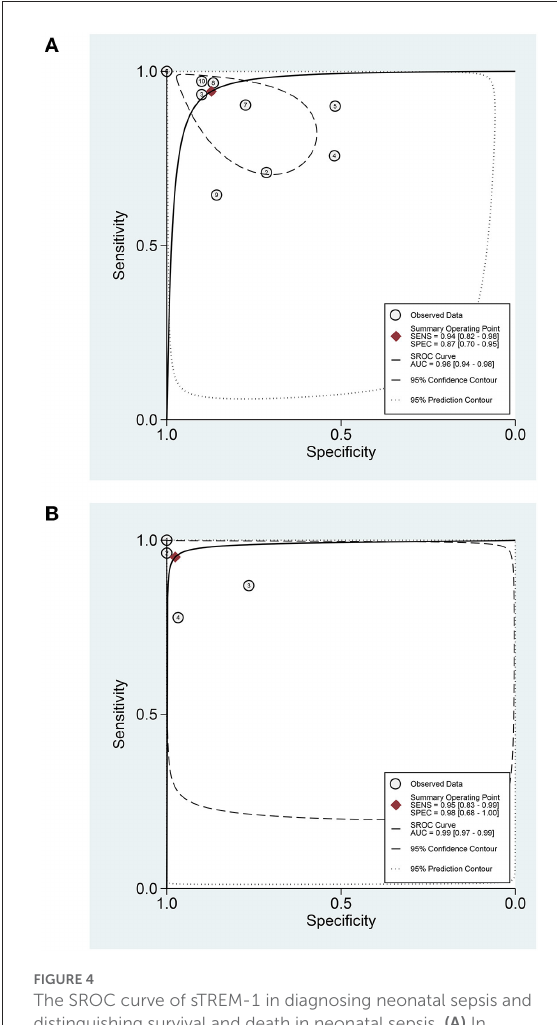
FIGURE4 The SROC curve of sTREM-1 in diagnosing neonatal sepsis and distinguishing survival and death in neonatal sepsis. (A) In diagnosing neonatal sepsis. (B) In distinguishing survival and death in neonatal sepsis. sTREM-1, soluble triggering receptor